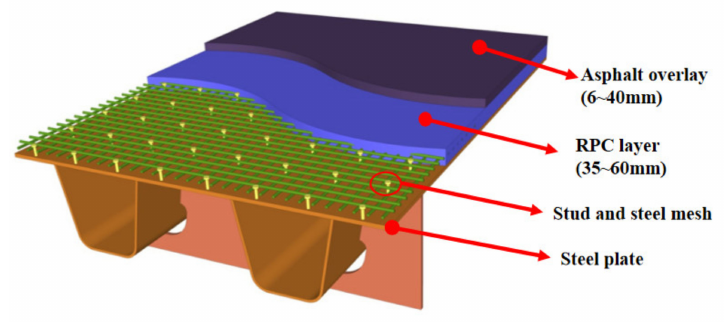
Figure 1. Lightweight composite bridge-deck structure with closed